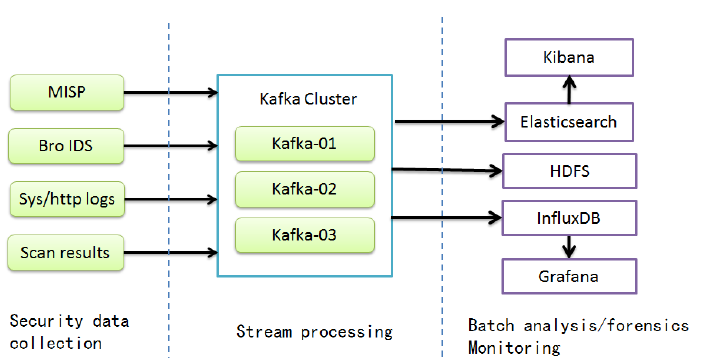
Figure 4. Architecture of security detection and monitoring